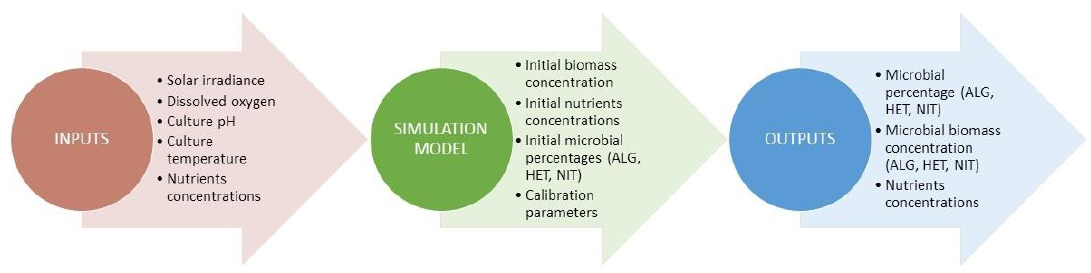
Figure 3. Model input-output diagram.